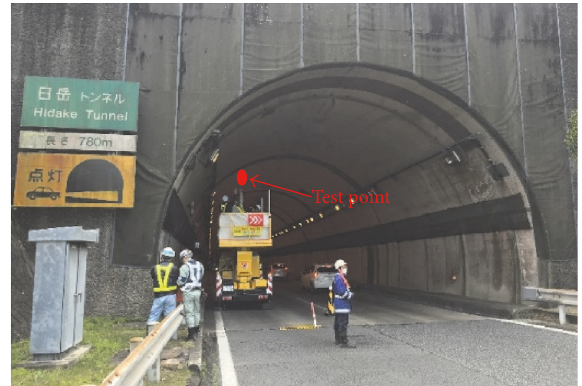
Figure 3: Ambient vibration test of Hidake Tunnel in